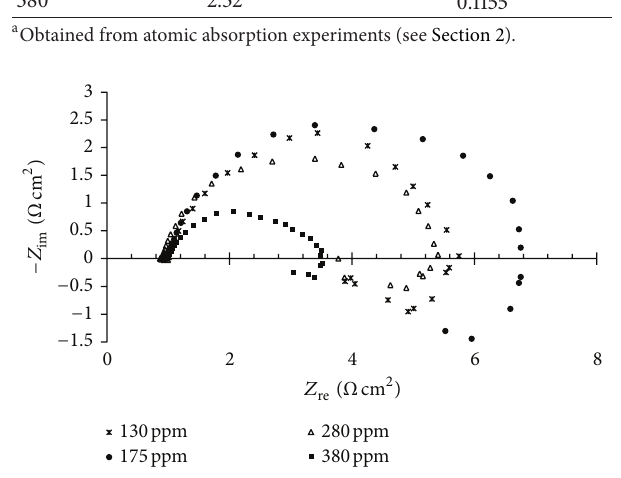
Figure 2: Nyquist diagrams of Pb-Ag electrode under anodic polarization regime in the electrowinning solution with different chloride contents ( 𝑖 = 500 A/m 2 , 𝑇 = 40 ∘